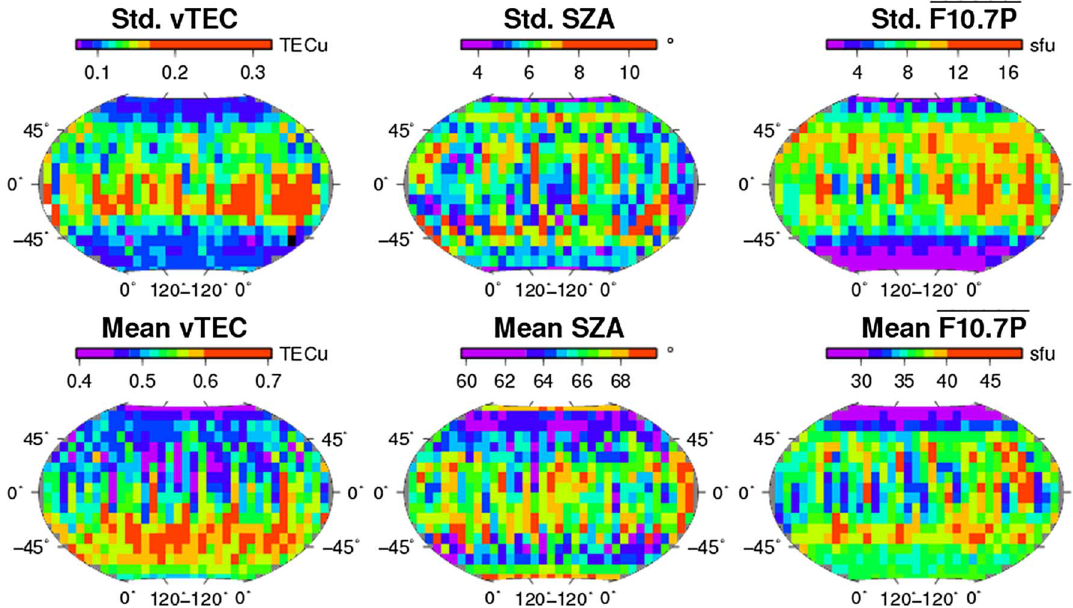
Fig. 2. vTEC, SZA and F 10 : 7 P distribution on Mars for SZA lower than 75 (cid:3) . Bottom: mean values every 10 (cid:3) in longitude and latitude for the entire period (2006 – 2014) for vTEC (left), SZA (middle) and F 10 : 7 P (right). Top: standard deviation of the mean at 1 r